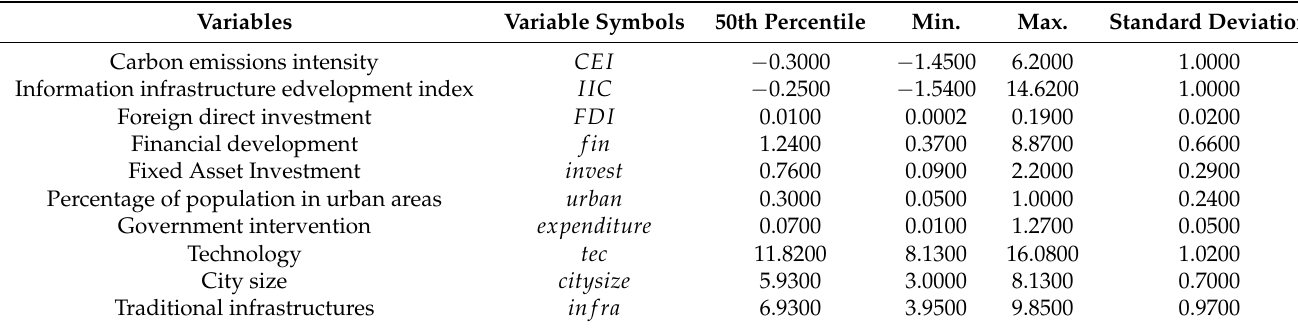
Table 1. Variables and descriptive